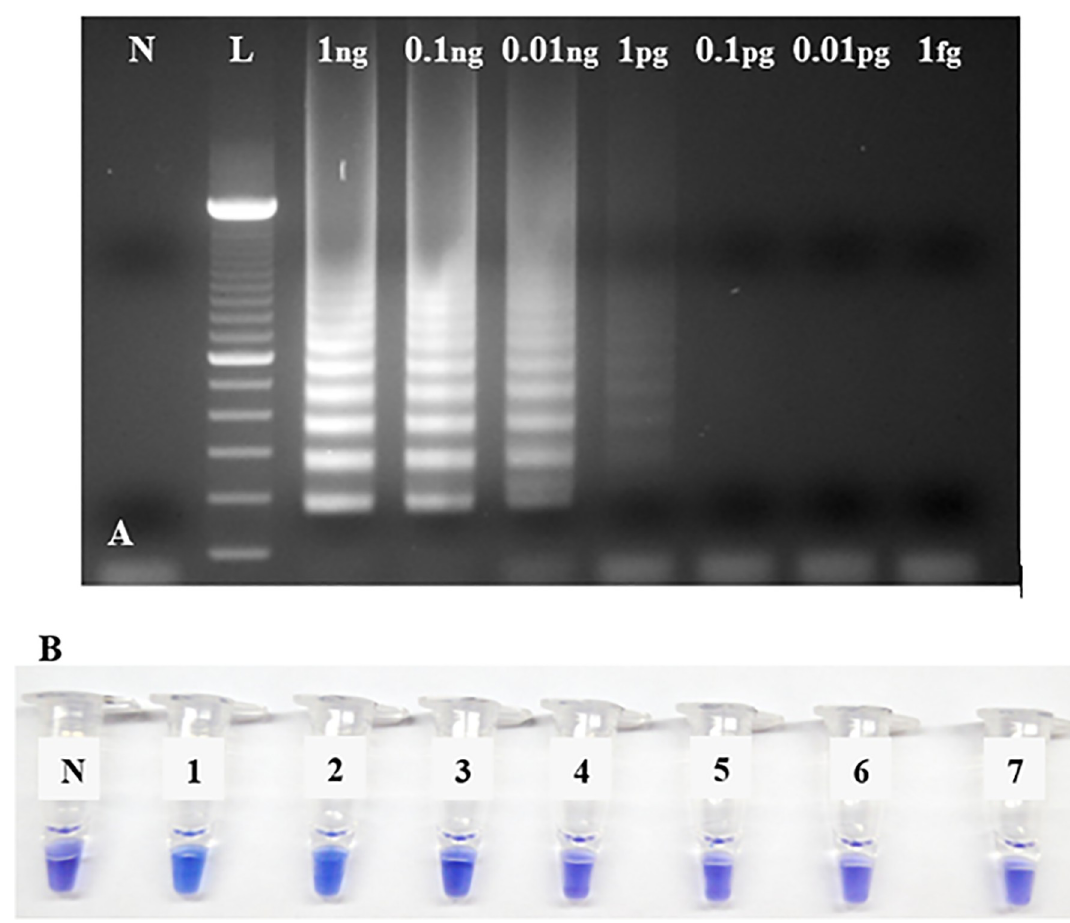
Fig 7. Limit of detection assay of RRV-P4 RT-LAMP performed with Bst 2.0 DNA polymerase. (A) Gel electrophoresis of RRV-P4 RT-LAMP products from RRV-P4 plasmid serially diluted from 1ng to 1fg limit. Lane N, is a non-template control (NTC, water); lane L, is a 100 bp DNA ladder. (B) Colorimetric RRV-P4 RT-LAMP using HNB. RRV-P4 plasmid was serially diluted from 1ng to 1fg. Tube N, is a non-template control (NTC, water); tube 1, 1ng/ μ L; tube 2, 0.1ng/ μ L; tube 3, 0.01ng/ μ L; tube 4, 1pg/ μ L; tube 5, 0.1pg/ μ L; tube 6, 0.01pg/ μ L; tube 7, 1fg/ μ